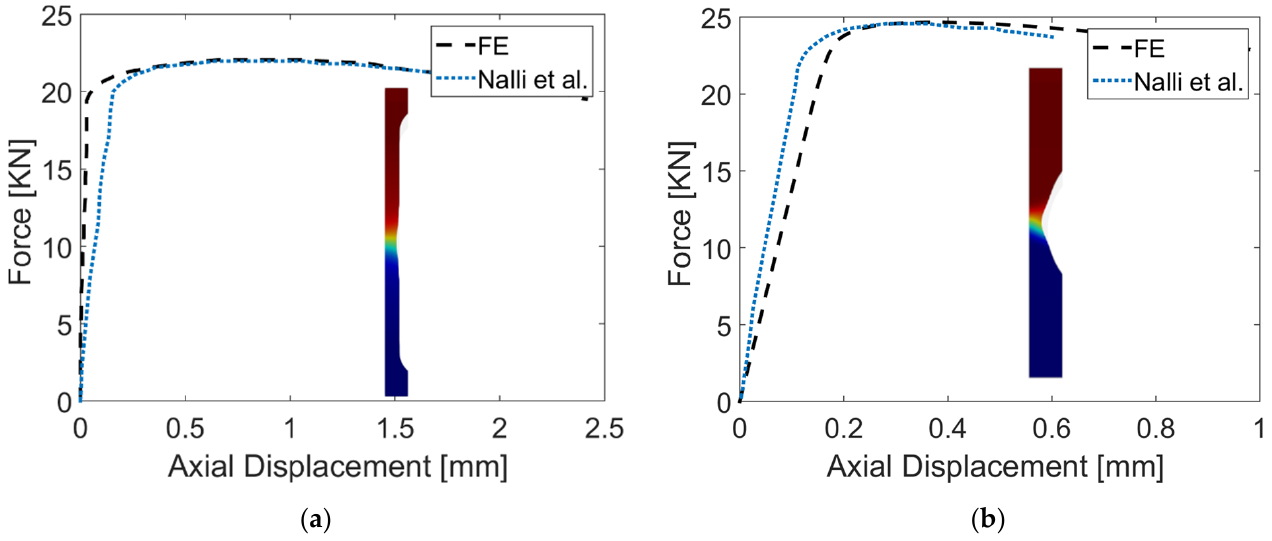
Figure 6. Force displacement curves of ( a ) round bar and ( b ) round notched bar compared with literature data.